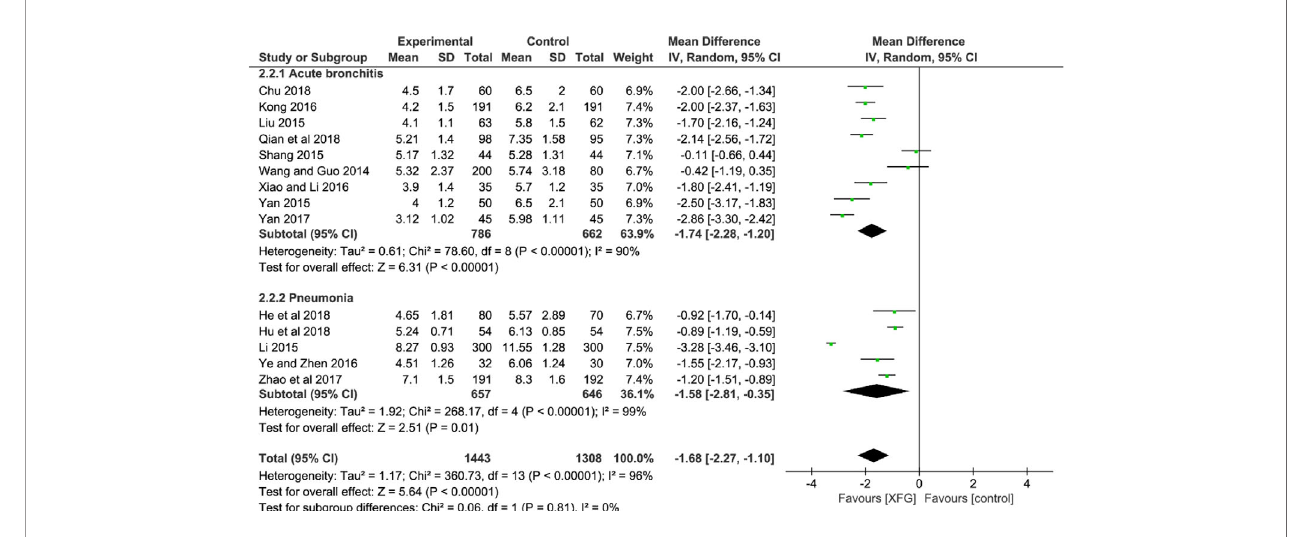
FIGURE 5 | Forest plot and subgroup analysis of the RTR.